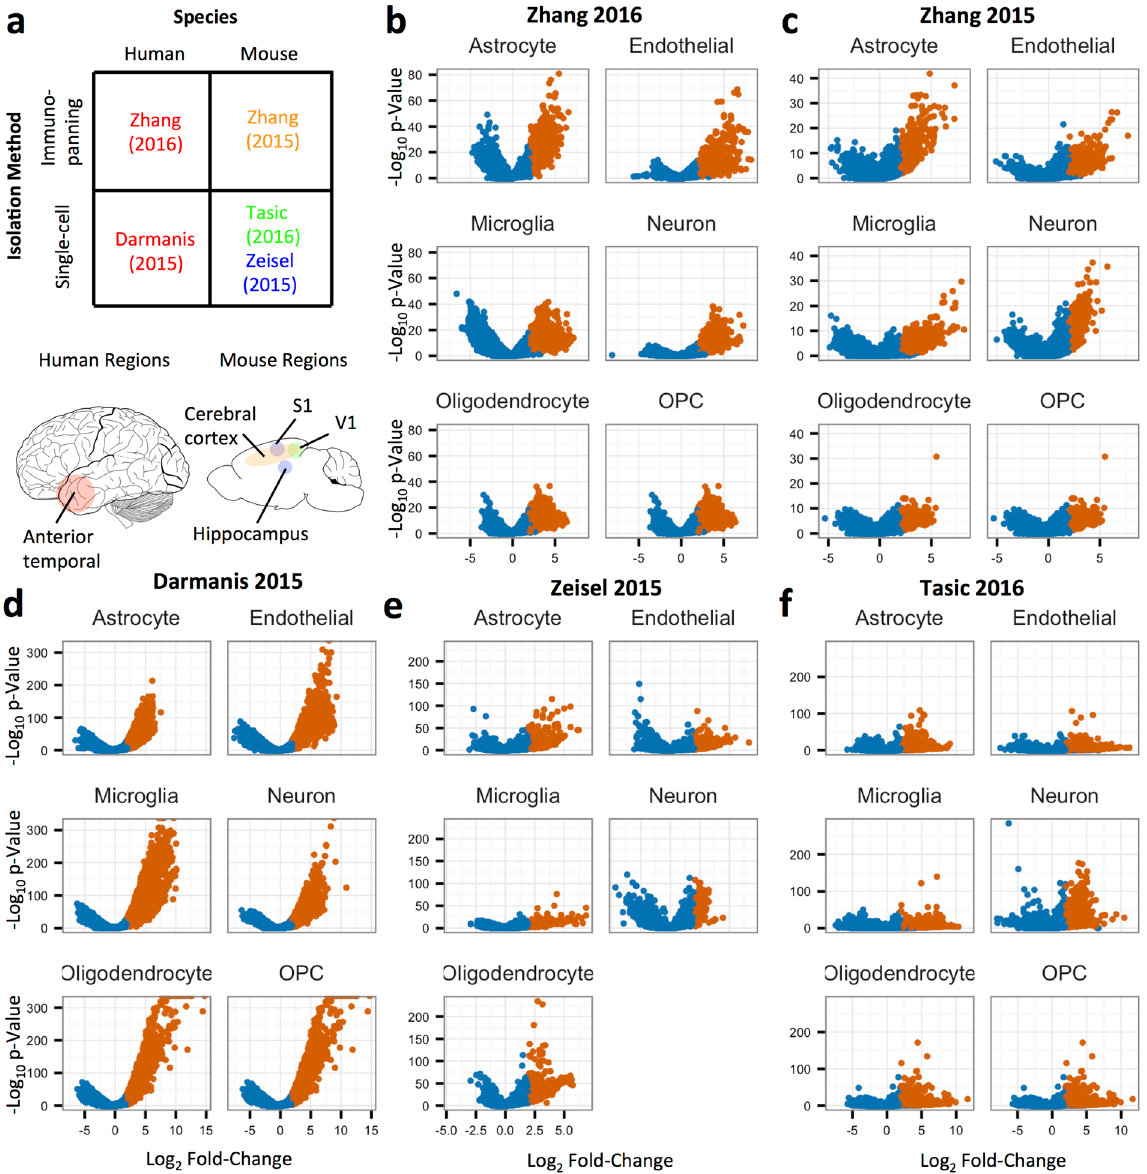
Figure 2. Differential expression volcano plots across cell types and data sets for cell type enrichment. ( a ) Summary of the five data sets used in this study indicating the region in which the cell types were isolated from in both the human (left) and mouse (right) brains. ( b–f) : Volcano plots show the cell type enrichment differential expression calculation for each cell type in each data set ( b = Darmanis et al . c = Zhang et al ., d = Zhang et al ., e = Zeisel et al . f = Tasic et al .). In each small multiple, the x-axis refers to the log2 fold-change of the gene in the cell type of interest compared to the reference cell set, while the y-axis shows the − log 10 Benjamini-Hochberg adjusted p-value of that comparison, calculated using edgeR. Genes with adjusted p-values < 0.05 and log fold-change > 2 are colored orange. OPC = Oligodendrocyte Precursor